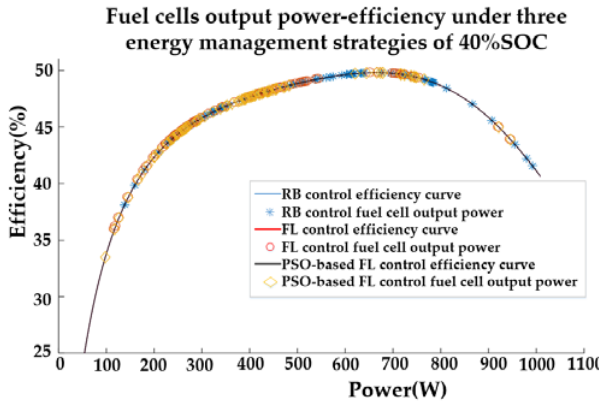
Figure 21. Efficiency curve of the fuel ‐ cell.